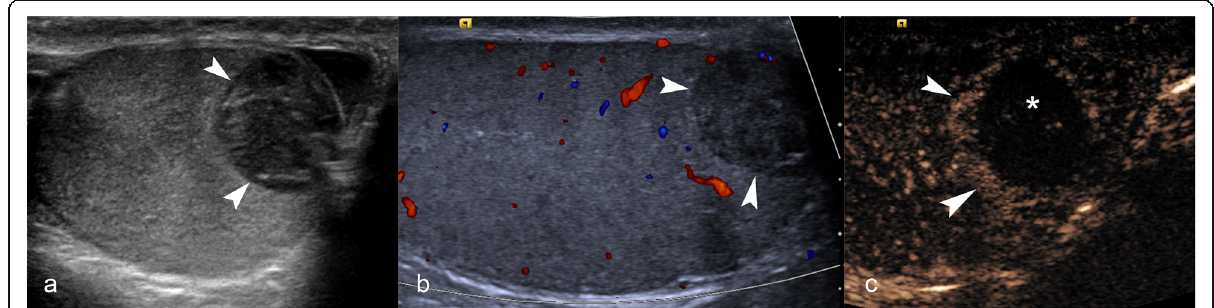
Fig. 2 CEUS appearances of intratesticular haematoma after blunt trauma. B-mode image ( a ) showing an intratesticular rounded hypoechoic lesion (arrowheads), associated with hydrocele. On colour Doppler US ( b ), the lesion (arrowheads) showed no internal blood flow signals. CEUS ( c ) confirmed the absence of internal vascularity (asterisk), then unlikely a tumour and in keeping with that of haematoma. Note the peri-lesional hyperaemia (arrowheads) and the presence of two internal echoes, representing artefact from echogenic content